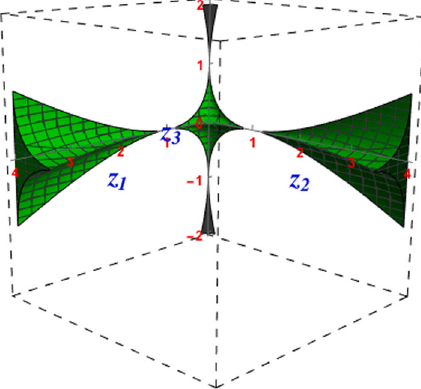
Fig. 5 Convergence regions given in Eq. (13) (left region with z 1 > 1) and Eq. (15) (right region with z 2 > 1), with the regions already shown in Fig.4 (central